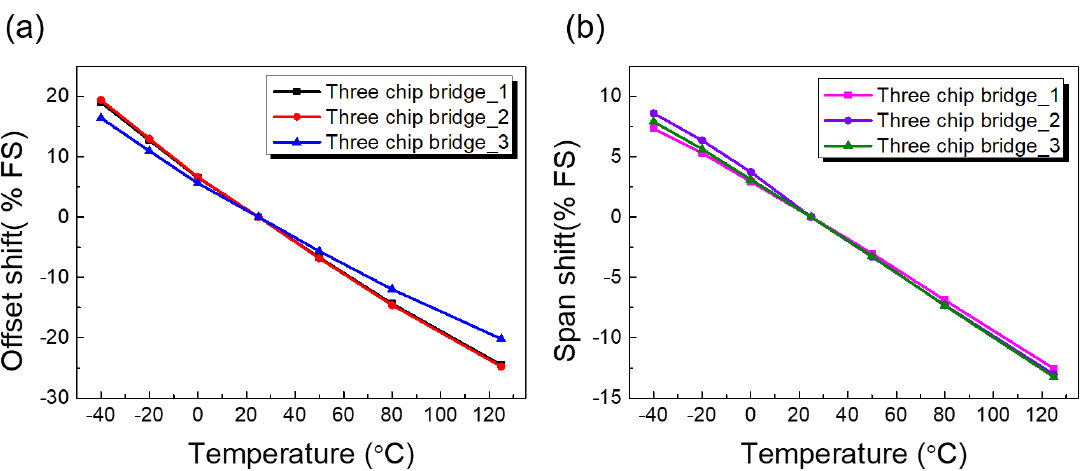
Figure 15. ( a ) Offset drift and ( b ) span drift results of a strain gauge with temperature variation.